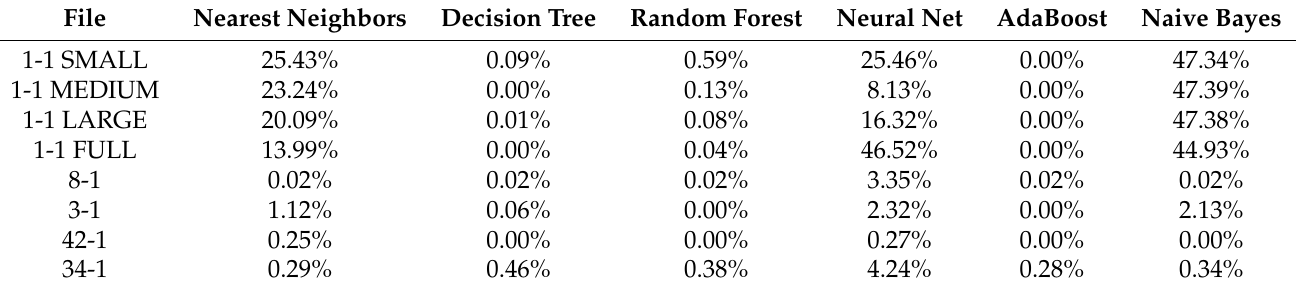
Table 4. False positive percentage of each algorithm per